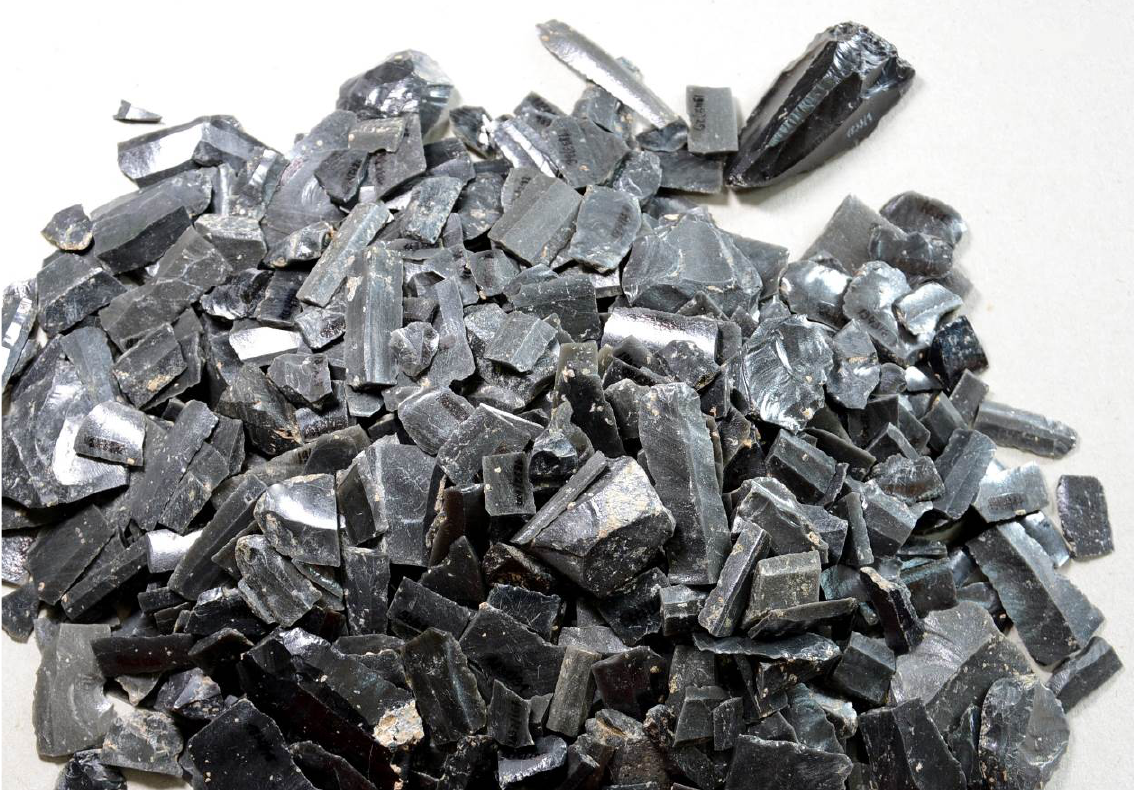
Figure 7. Çukuriçi Höyük phase X obsidian assemblage made of Melian obsidian (photo by B. Milić